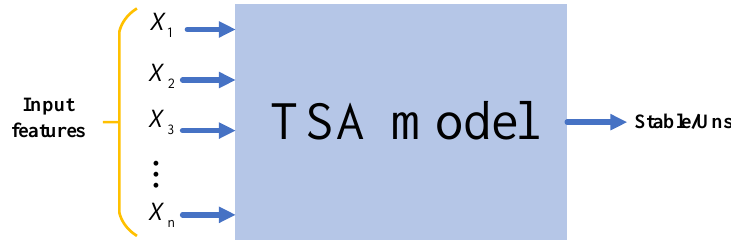
Figure 1. Schematic diagram of data-driven TSA.